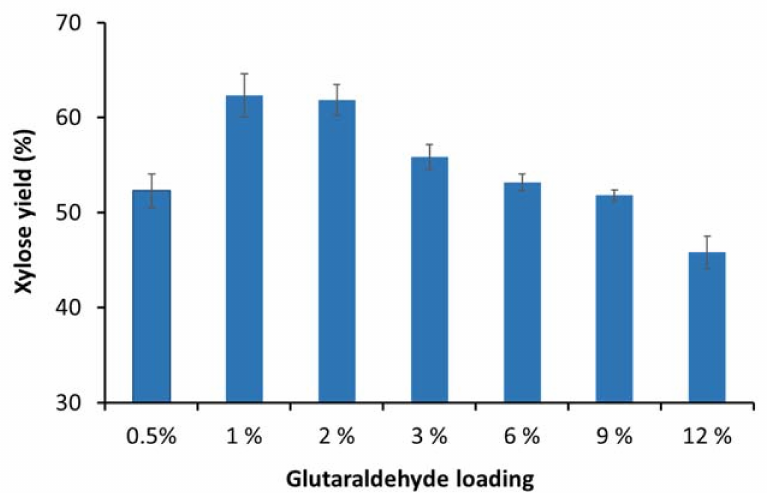
Figure 2. Hydrolysis of xylooligomer-enriched pre-treatment liquors after 24 h using immobilized xylanase enzymes on activated alginate beads with various glutaraldehyde